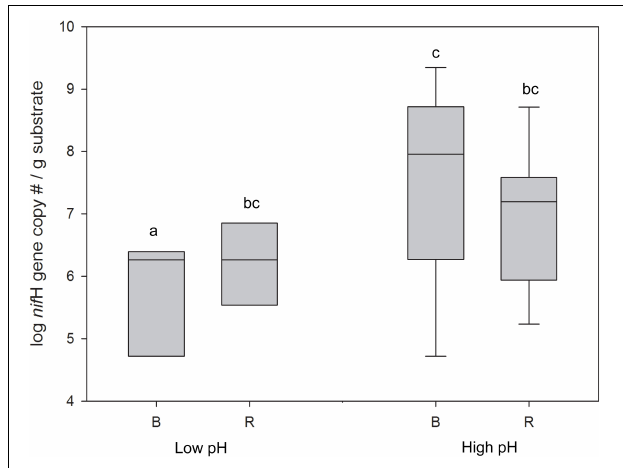
FIGURE 5 | nif H gene abundance in buffalo grass bulk and rhizosphere samples from high pH ( > 4) and low pH ( < 4) substrate. Different letters indicate significant difference (ANOVA, p < 0.05). B, bulk; R, rhizosphere.